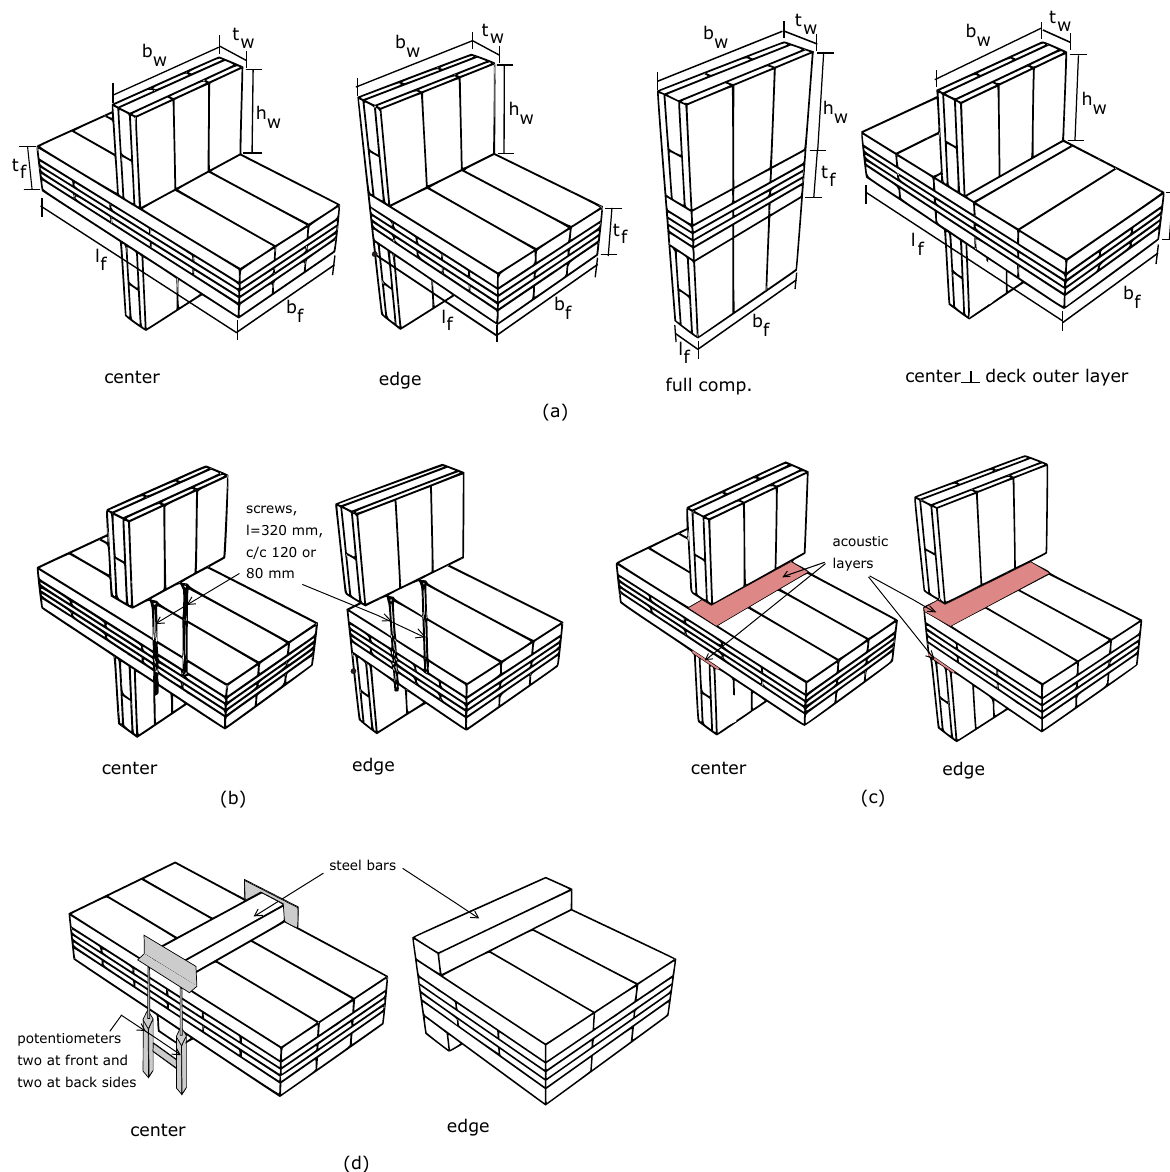
Figure 1. CLT connection tests with different connection types and positions of load; ( a ) wood-to-wood connection, ( b ) connection with screws, ( c ) connection with acoustic layers, and ( d ) connection loaded and supported with steel